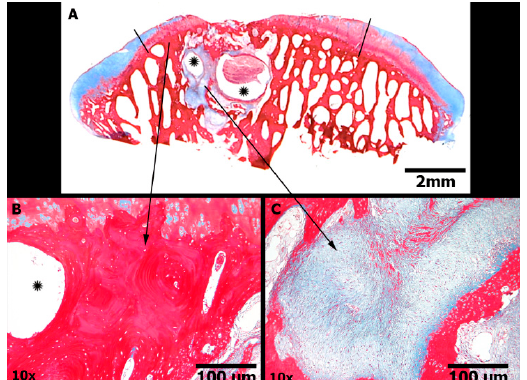
Figure 8. Subchondral bone damage (Masson’s trichrome stain). Group SCAFFOLD. ( A ) Panoramic view of the articular surface in the region of the defect (delimited by black lines) showing cartilage border centripetal ingrowth. Evident cystic formations were noted (asterisk) in a localized area of subchondral bone, surrounded by loosely immature fibrous connective tissue and new sclerotic bone, similar to the findings of advanced degenerative joint disease; Scale bars represent 2 mm; ( B ) Sclerotic bone; Scale bars represent 100 μ m; ( C ) Immature fibrous tissue; Scale bars represent 100 μ m.